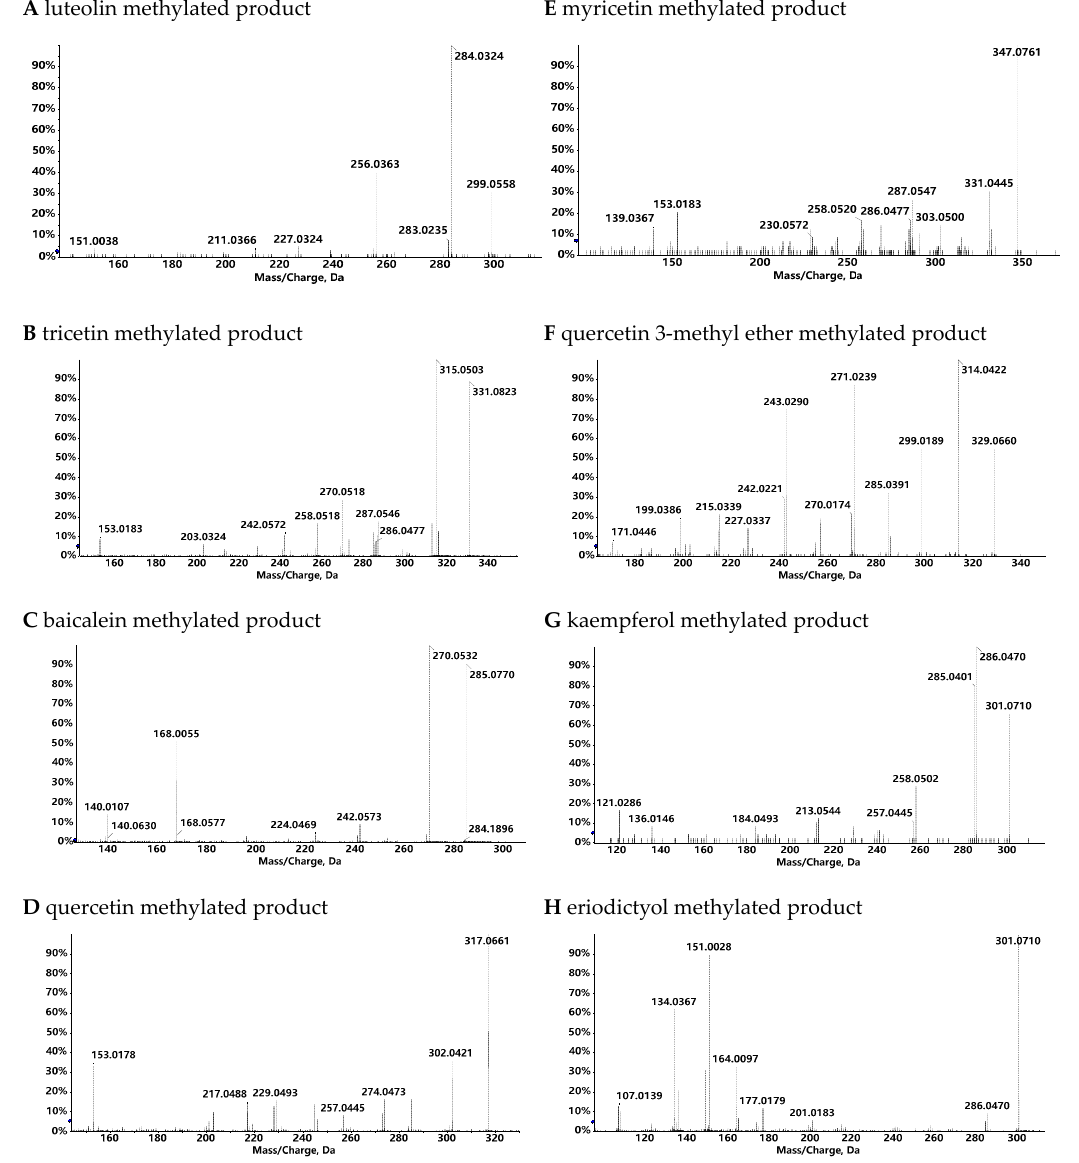
Figure 4. MS/MS spectra of the methylated products catalyzed by Citrus reticulata O -methyltransferase 2 (CrOMT2). Substrates utilized were luteolin ( A ), tricetin ( B ), baicalein ( C ), quercetin ( D ), myricetin ( E ), quercetin 3-methyl ether ( F ), kaempferol ( G ), and eriodictyol ( H ). ( A , F , H ) were operated in negative ion mode and the rest were in positive ion mode. The y axis represents the percent intensity.